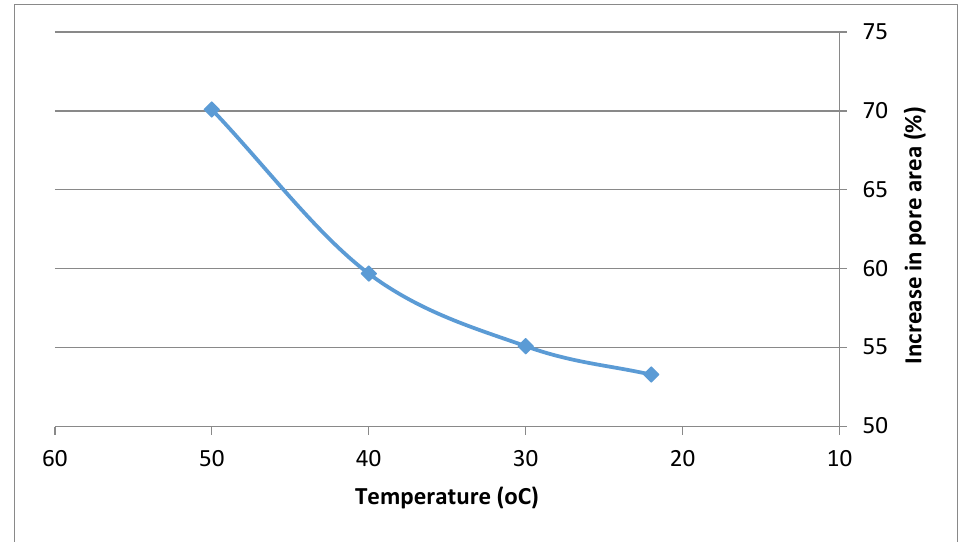
Figure 8. The increase in pore area (%) as a function of acidizing temperature.